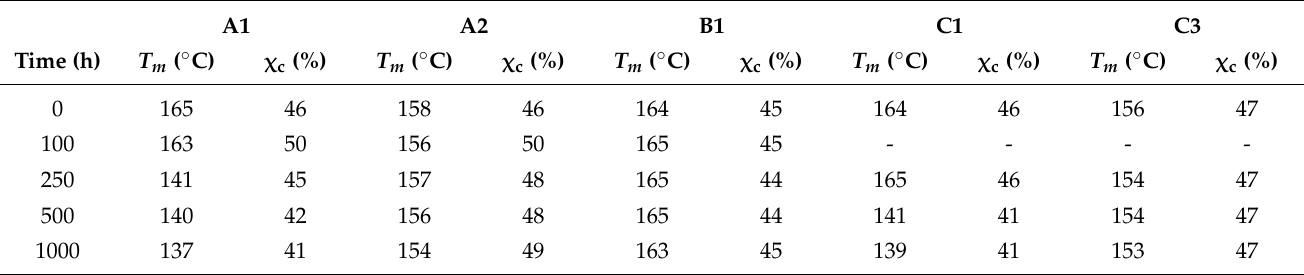
Table 2. The temperature of the main melting peak and χ c of the PP layers as a function of the time of isothermal treatment at 110 ◦ C. Values refer to the second scan.